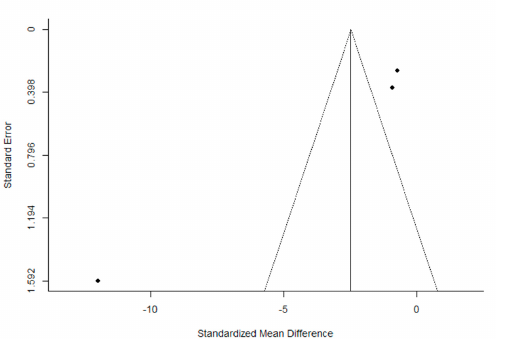
Figure 3. Funnel plot of the meta-analysis of the published studies. Each plotted point represents the standard error (SE) and the standardized mean difference (SMD) between post-intervention and pre- intervention urinary loss in women who received PFMT for a single study.